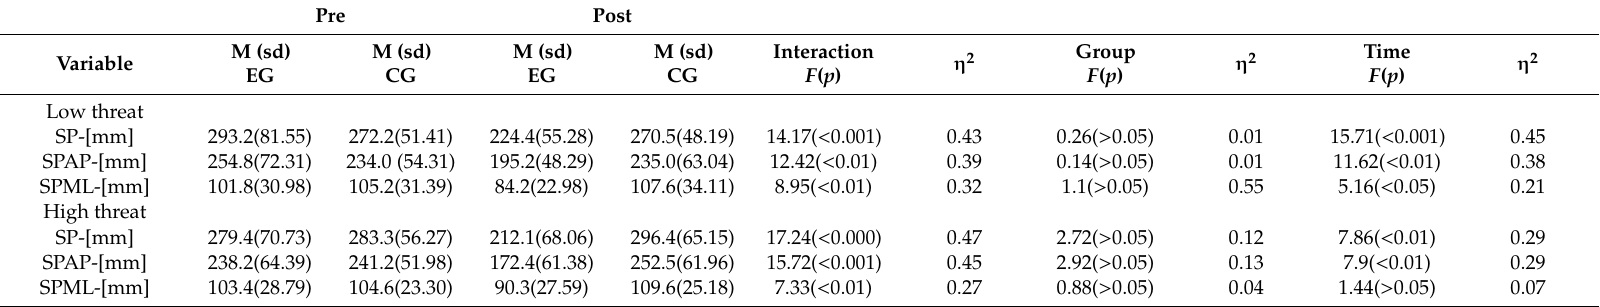
Table 4. Mean and standard deviation values of postural stability for quiet standing with eyes closed on low and high threat in the experimental and the control groups before and after intervention and results of two-way ANOVA.